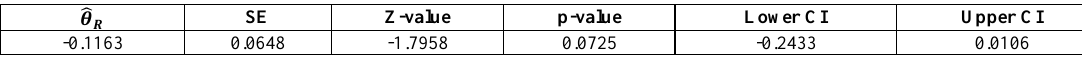
Table 8. Estimate for random effects model